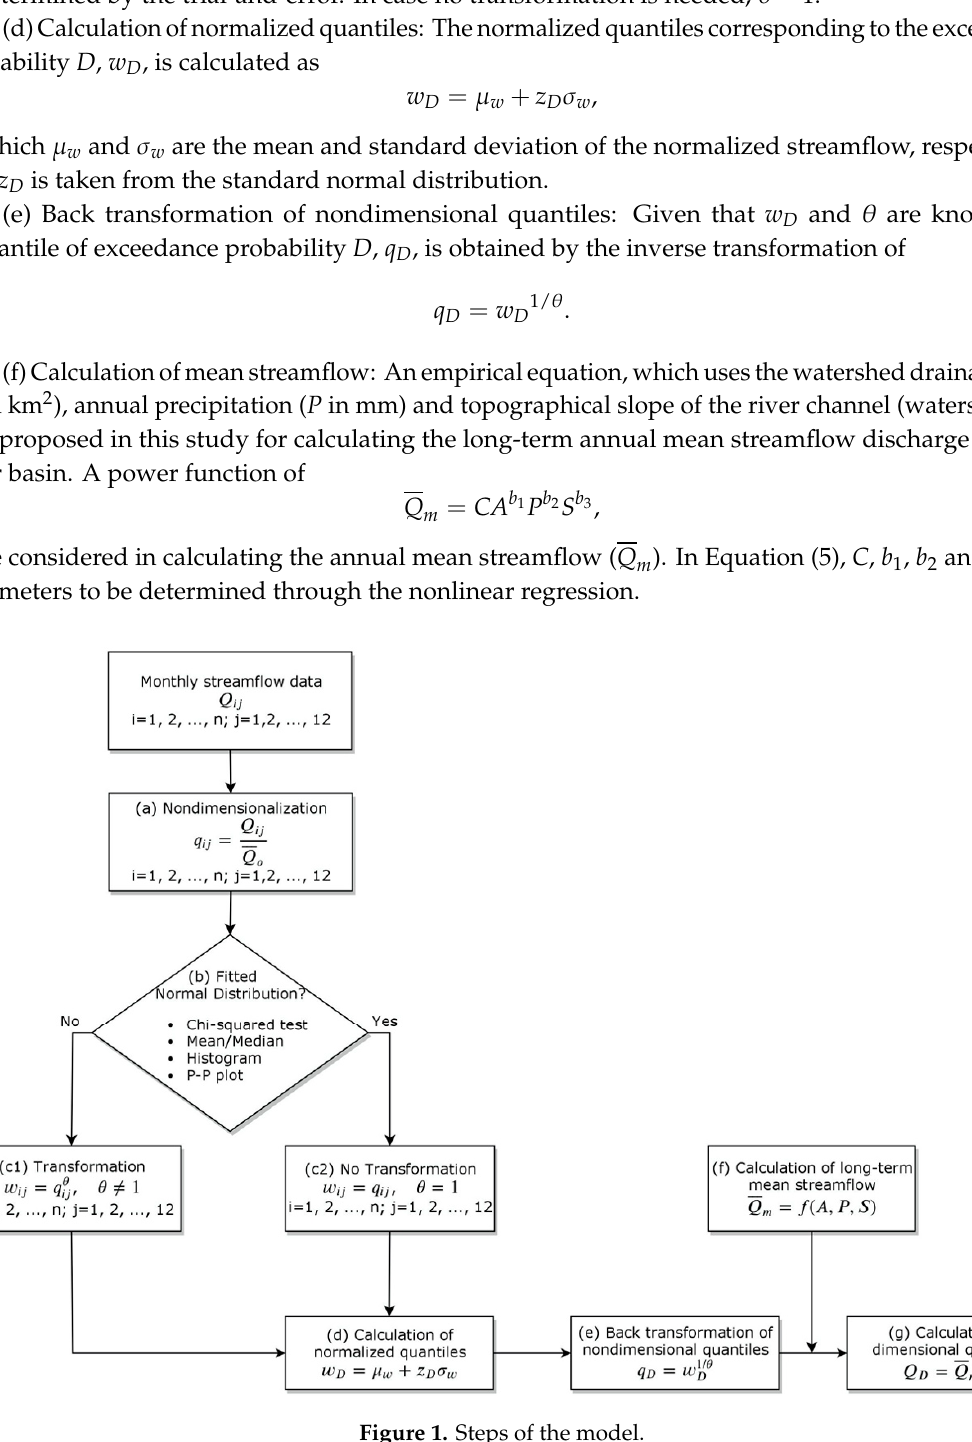
Figure 1. Steps of the model.